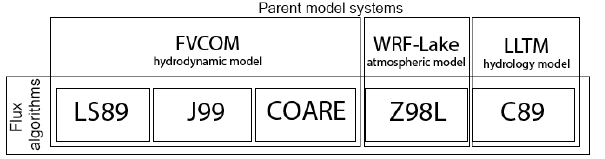
Figure 2. Schematic diagram showing the relationship between the parent model systems (FVCOM, WRF-Lake, and LLTM) and the flux algorithms used in the parent model systems. A detailed de- scription of each flux algorithm is listed in Table